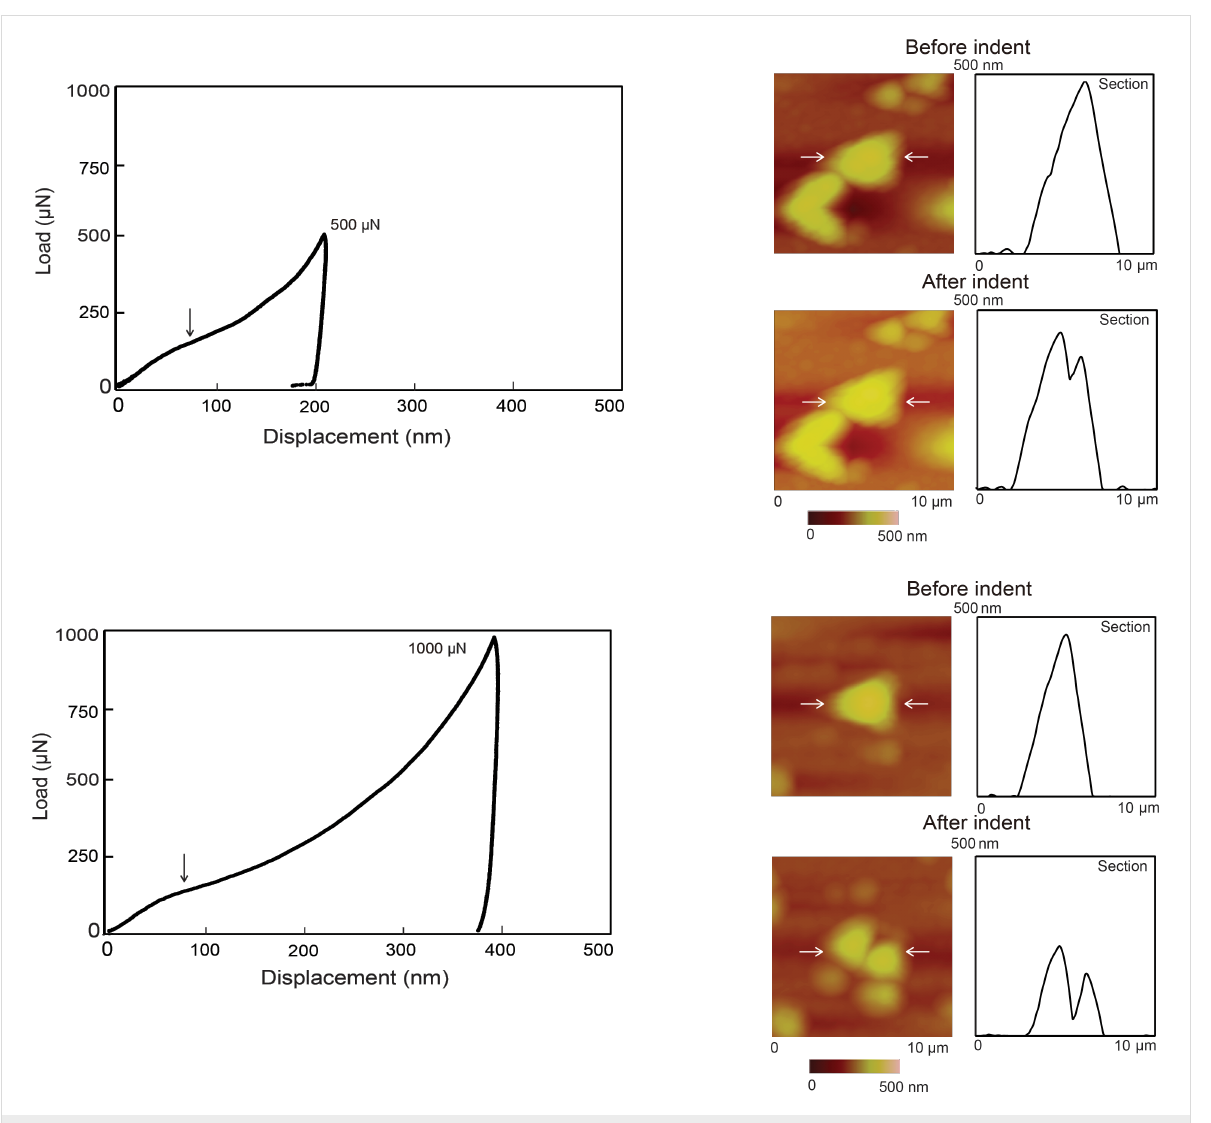
Figure 9: Load displacement curves for intermediate loads 500 µN and high loads 1000 µN for Au 500 with the vertical arrows depicting slip events (left), and topography maps and 2-D profiles, at sections indicated by the horizontal arrows before indentation (first row) and after indentation (second row)